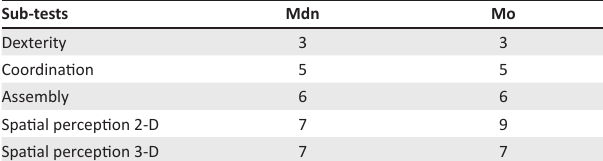
TABLE 1: Medians and modes of Trade Aptitude Test Battery